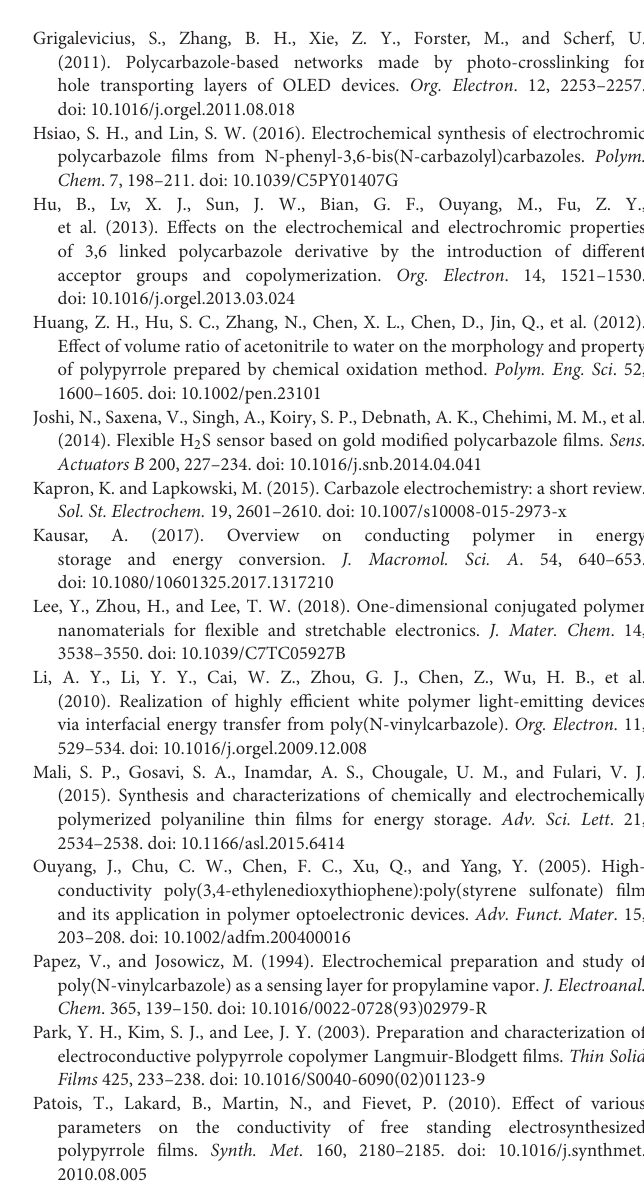
Figure S1 | 1 H and 13 C NMR spectra of synthesized carbazole